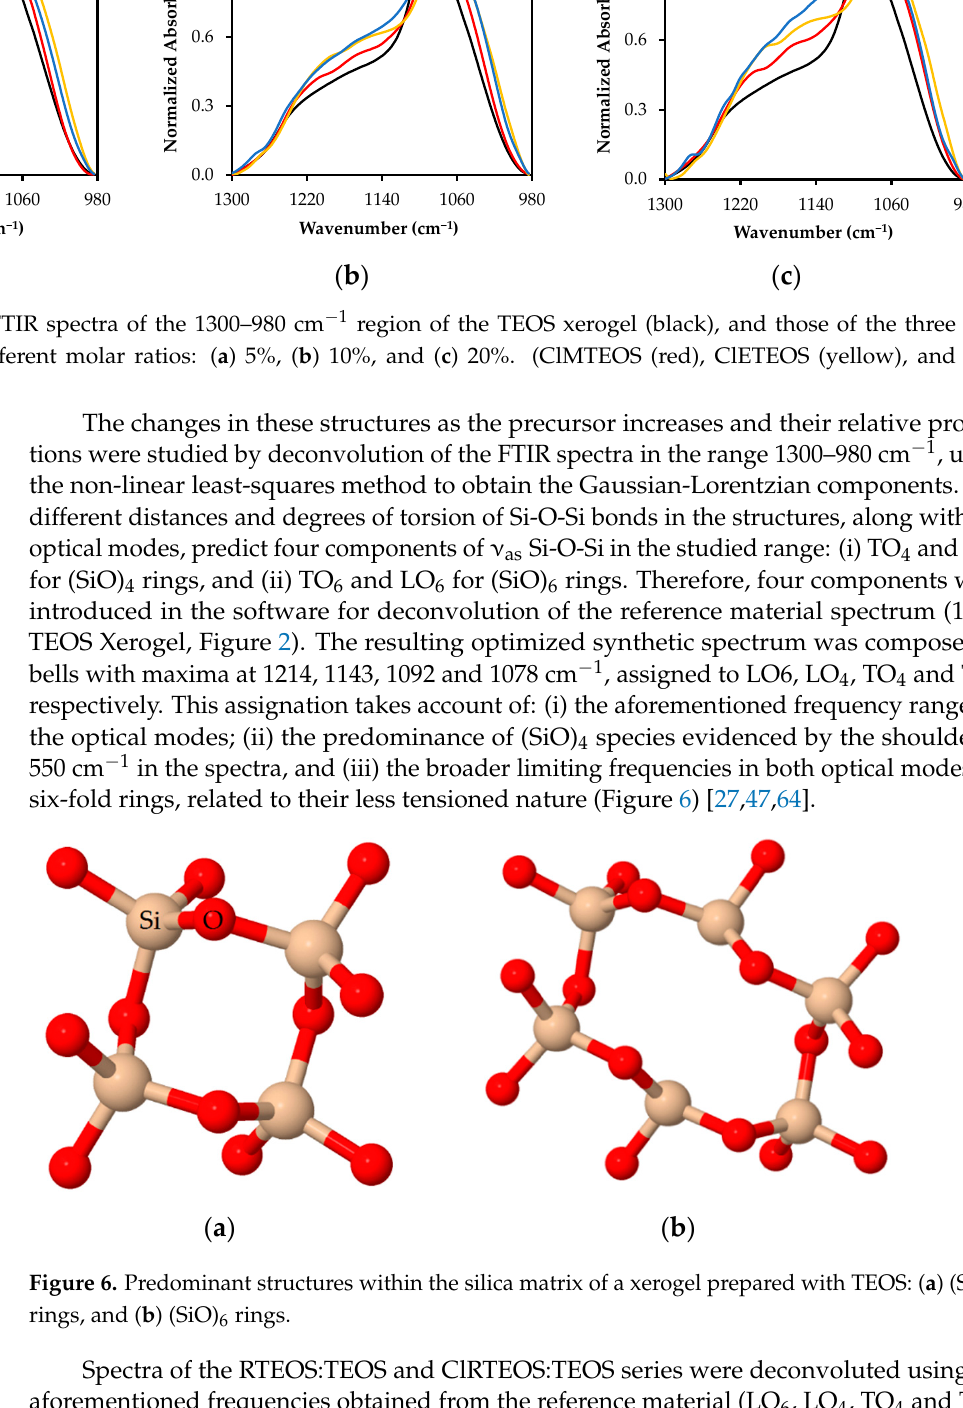
( b ) Figure 4. X-Ray diffraction spectra of the hybrid xerogels at different molar percentages (normalized with respect to the band 2 θ ~4°: ( a ) ClETEOS:TEOS, and ( b ) ETEOS:TEOS. 3.3. Spectral Deconvolution of the 1300–700 cm − 1 Region Figure 5 depicts the ν as Si-O-Si band at 1090 cm − 1 and the associated shoulder at around 1200 cm − 1 . It shows the shift at lower frequencies of the band at 1090 cm − 1 with higher molar percentages of the precursor as well as the overlapping bands derived from the shoulder at 1200 cm − 1 . These emerging bands are attributable to the different structures that make up the siloxane bonds, mostly forming rings of four or six silicon atoms, (SiO) 4 and (SiO) 6 respectively. The relative abundance of these rings depends on the nature and molar ratio of the precursor: four-fold rings are the predominant species in xerogels and are thermo- dynamically favored in the oligomerization of TEOS at acid pH through cyclodimerization